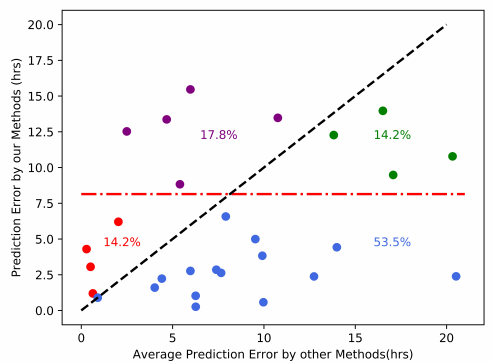
Figure 10. Compared with other methods on the arrival time prediction for each CME event on the testing